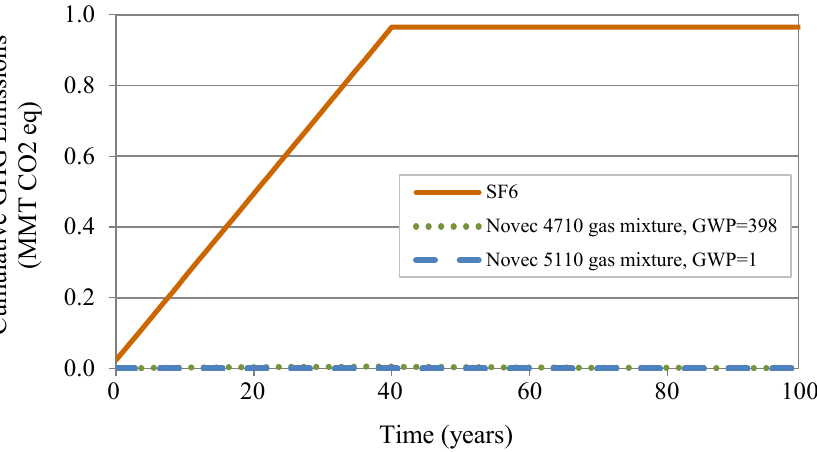
Figure 6. Cumulative greenhouse gas emissions, assuming emission equivalent to 1T/yr of SF 6 for 40 years of operation.